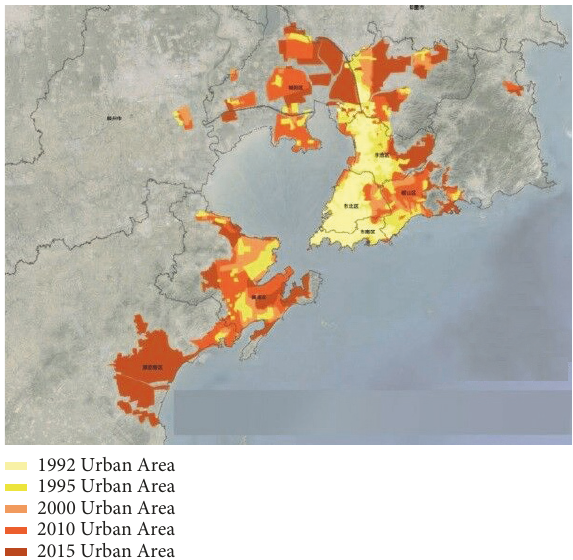
Figure 3: Urban area change of Qingdao from 1992 to